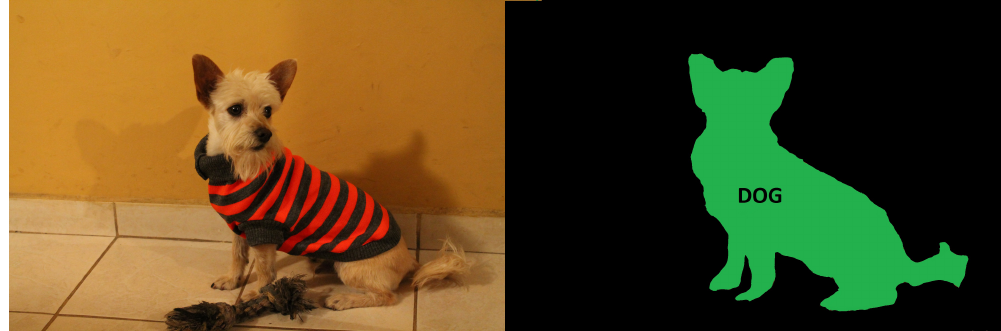
Figure 2. On the left side the input image and on the right the image where the dog is